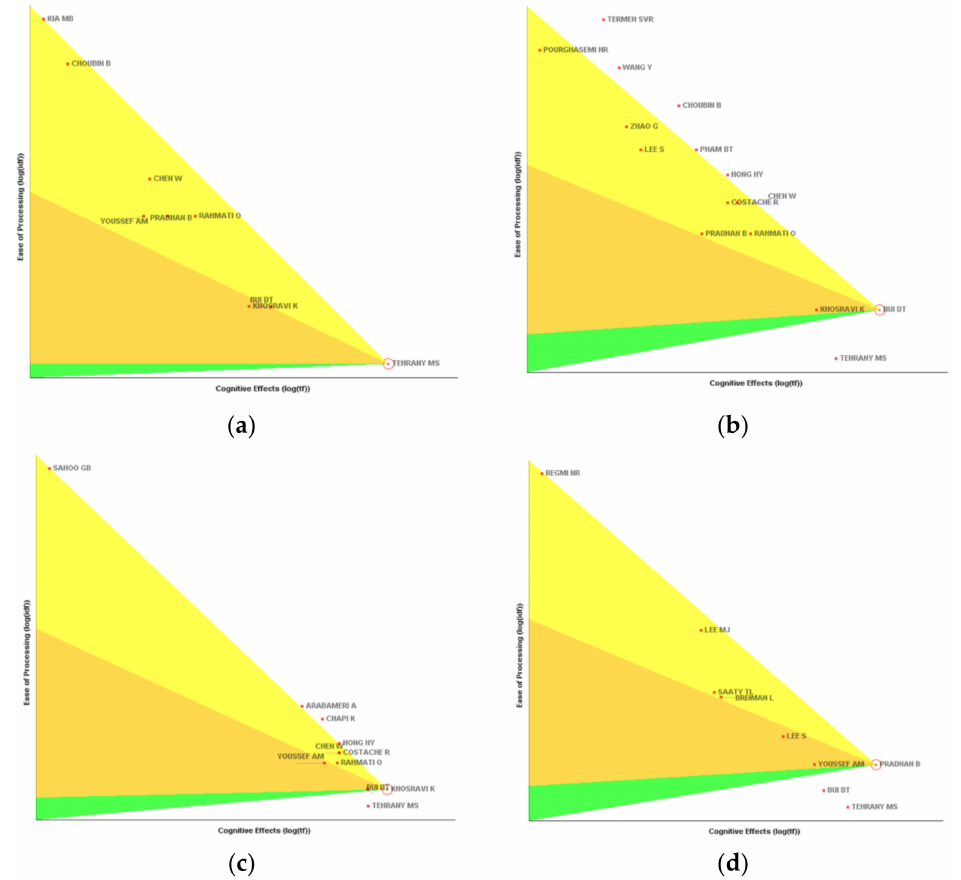
Figure 10. Diagram of pennant figures of the top four cited authors. ( a ). Diagram of pennant figures of Tehrany. ( b ). Diagram of pennant figures of Bui. ( c ). Diagram of pennant figures of Khosravi. ( d ). Diagram of pennant figures of Pradhan.